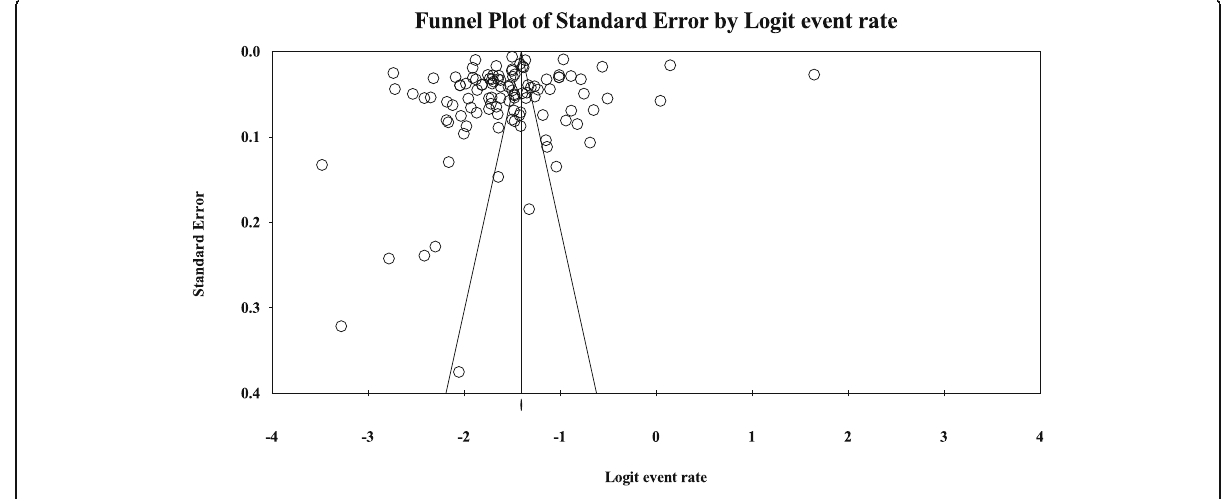
Fig. 4 Funnel plot for the meta-analysis of the prevalence of hyperuricemia in mainland